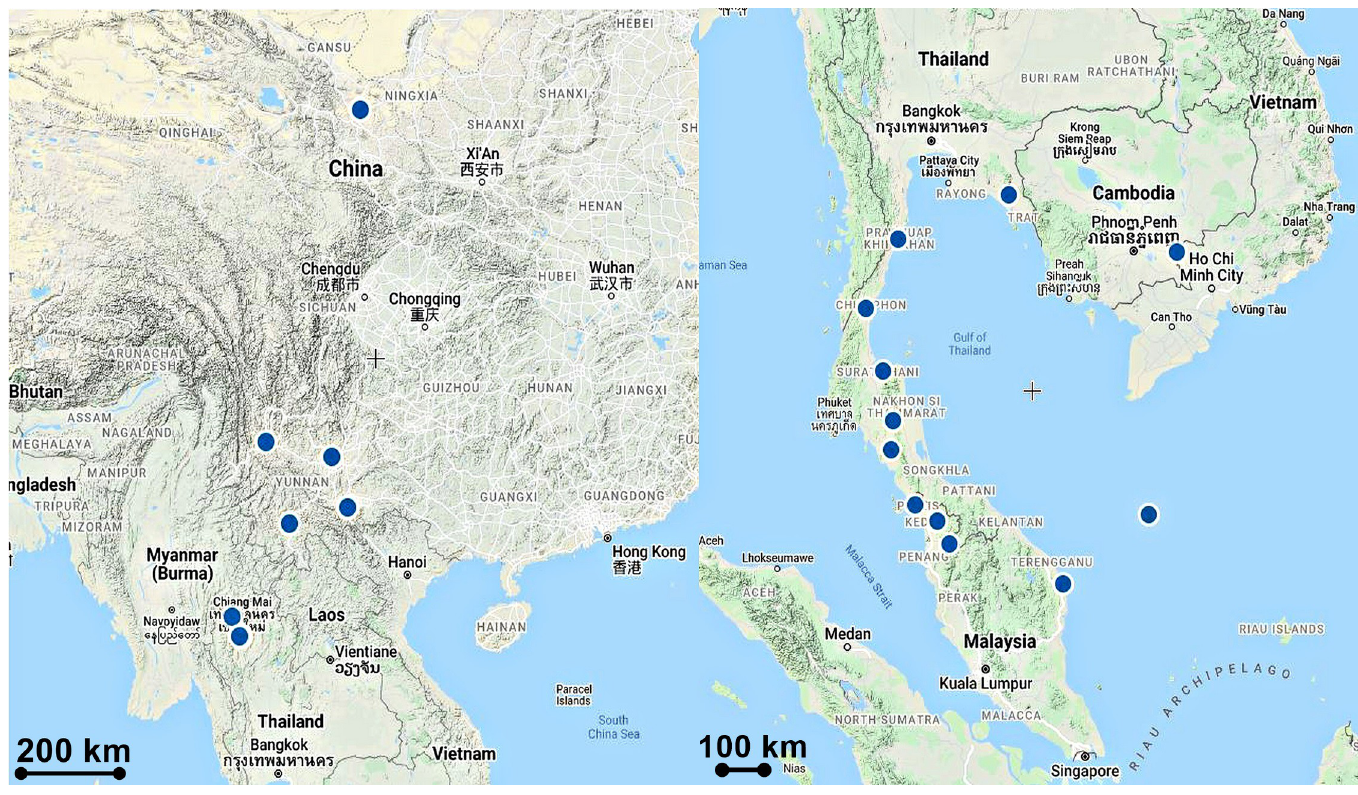
Fig 9. Distribution of Habenaria rostellifera